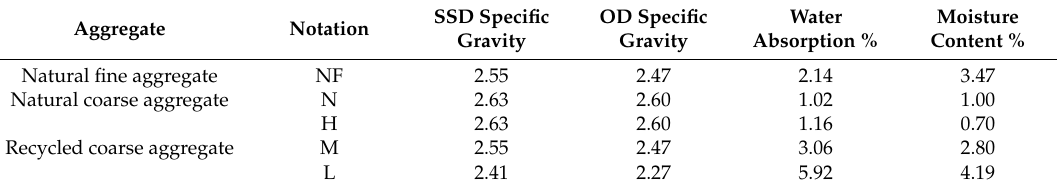
Figure 4. Cross-sections of the natural and recycled coarse aggregates. ( a ) Natural coarse aggregate; ( b ) high-quality recycled coarse aggregate; ( c ) medium-quality recycled coarse aggregate; ( d ) low-quality recycled coarse aggregate. Table 2. Physical properties of the coarse aggregate. SSD: Saturated-surface dry; OD: Oven-dry.